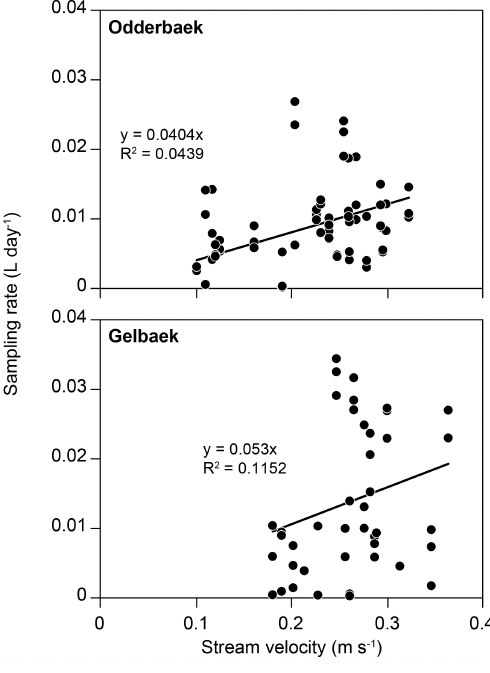
Figure 5. Relationships between stream flow velocity at Odderbaek and Gelbaek and the sampling rate of the passive